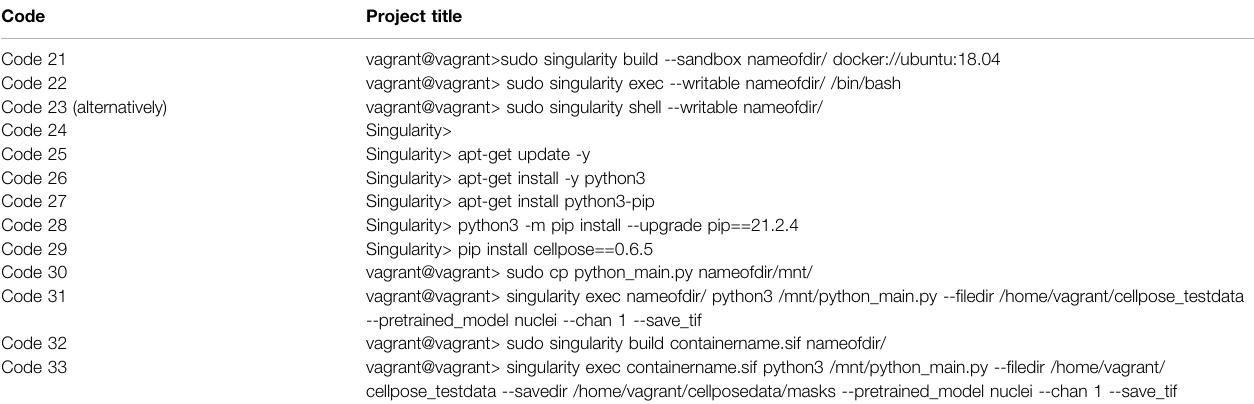
TABLE 2| Code used for establishing asandbox container. Please notethat copying text from the table might introducesomeerrors,particularlyfor thehyphens.In case of errors, we suggest typing the code newly in the command